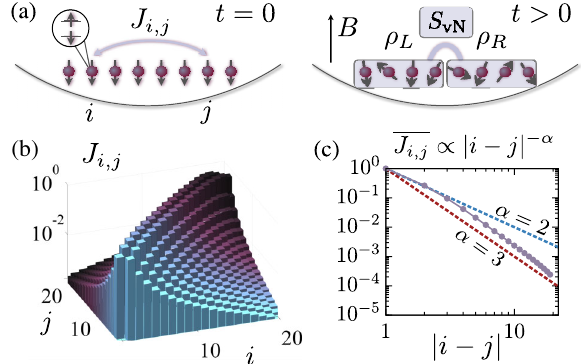
FIG. 1. (a) Illustration of the quench experiment. We consider a linear chain of ions (effective spin model) with long-range interactions. Initially, all spins are fully polarized along the axis of the magnetic field B . After a time evolution, spatial entangle- ) builds up between blocks of the system. ment entropy ( S vN (b) A typical calculated experimental interaction matrix for 20 ions (see text for further details and parameters). (c) The decay of the interactions with a tunable decay exponent (cid:1) . Here, the grey dots show the mean interactions from diagram